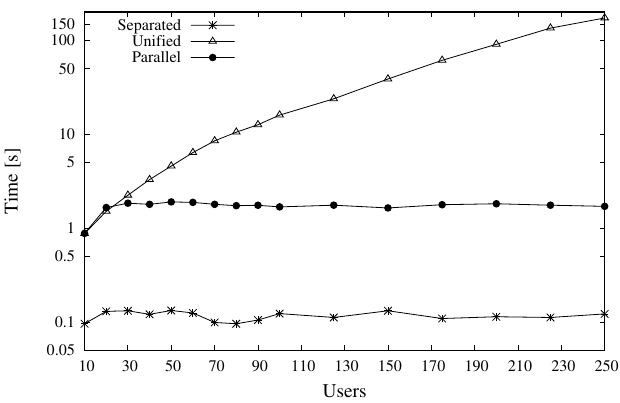
Figure 8. Computing time needed to solve the prosumer problem versus the number of users. Comparison among the Separated, Unified, and Parallel approach. The group size of the Parallel approach is set to 10.